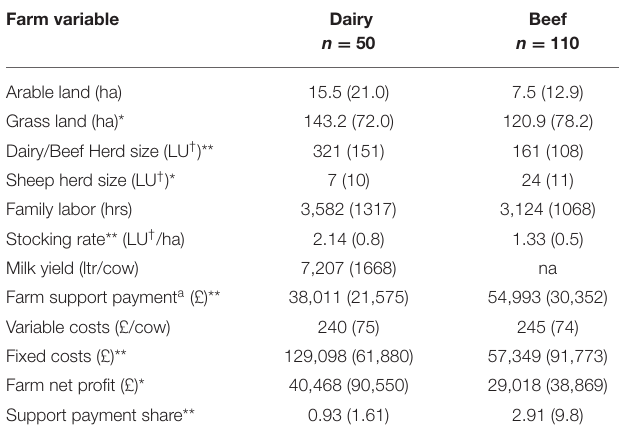
TABLE 3 | Average farm variables on Scottish dairy and beef farms (st. dev. in parenthesis).